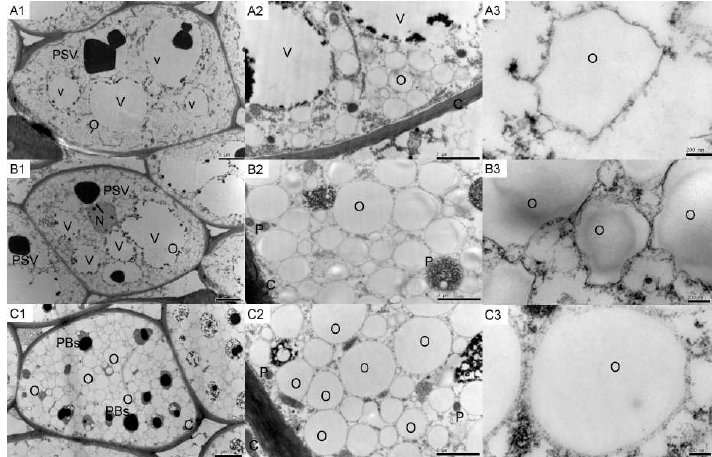
Figure 1. Ultrastructural observations of tung tree seeds across three development stages. Tung tree seeds prepared on: 25 August ( A ); 9 September ( B ); and 26 September ( C ). Images of: the whole tissue sample ( 1 ); cell sections ( 2 ); and single oil bodies ( 3 ). O, oil body; PSV, protein storage vacuole; PBs, protein bodies; P, protein particle; V, vacuole; C, cell wall; and N, nucleus.